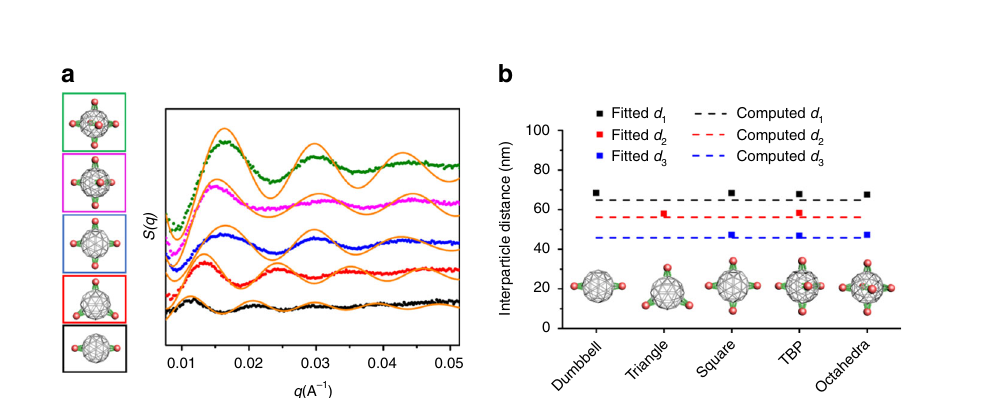
Fig. 2 Structures of NP cluster architectures assembled by programmed meshframe and revealed by TEM and cryo-TEM tomography. a (From top to bottom) Designed DNA meshframes with different valence numbers: two, three, four, fi ve, and six, corresponding to the geometry of dumbbell, triangle, square, TBP and octahedra, respectively. b NPs decorated with DNA are assembled into clusters, whose architecture is determined by the meshframe valence mode. c Representative negative-stained TEM images of assembled NP clusters based on meshframes with different valence modes; scale bar, 100 nm (insets: zoomed-in images; side length, 70 nm). d NP cluster population histograms. e Reconstructed 3D structure of TBP cluster from cryo-TEM based tomography (top). Designed center-to-center distances between NPs (bottom, shadow columns): d 1 = 64.8 nm, d 2 = 56.1 nm, and d 3 = 45.8 nm. Measured distances between NPs of one reconstructed cluster (bottom, solid columns): d 1 = 64.6 nm, d 2 = 55.8 ± 2.7 nm, and d 3 = 46.1 ± 2.1 nm. f Reconstructed 3D structure of octahedral cluster by cryo-TEM tomography (top). Designed NP distances (bottom, shadow columns): d 1 = 64.8nm and d 3 = 45.8 nm, and measured cryo-TEM tomography distances averaged over two independently reconstructed clusters (bottom, solid columns): d 1 = 66.3 ± 2.0 nm and d 3 = 46.9 ± 3.8 nm. Error bars indicate standard deviation of experimental data.